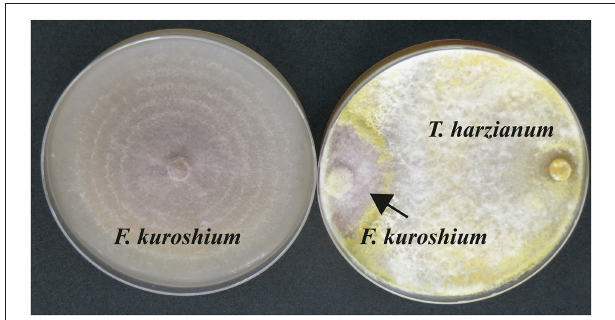
FIGURE 2 | (Left) Culture of F. kuroshium in the absence of the antagonistic fungus (control); (Right) in vitro overgrowth of Trichoderma harzianum on Fusarium kuroshium